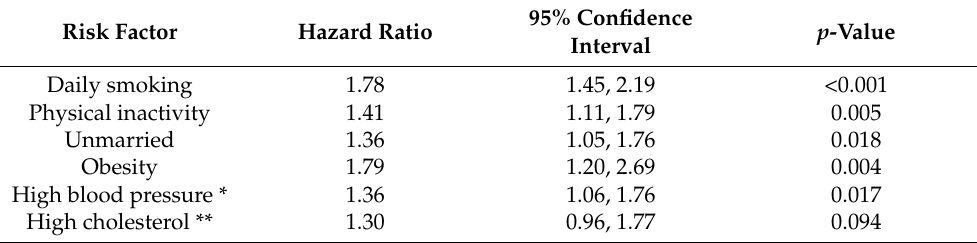
High blood pressure * High cholesterol ** 0.96, 1.77 0.094 Obesity: body mass index ≥ 30 kg/m 2 ; high blood pressure *: systolic blood pressure ≥ 140 mmHg and diastolic blood pressure ≥ 90 mmHg, or blood pressure medication; high cholesterol **: ≥ 8.26 mmol/L, i.e., the 90% quantile.